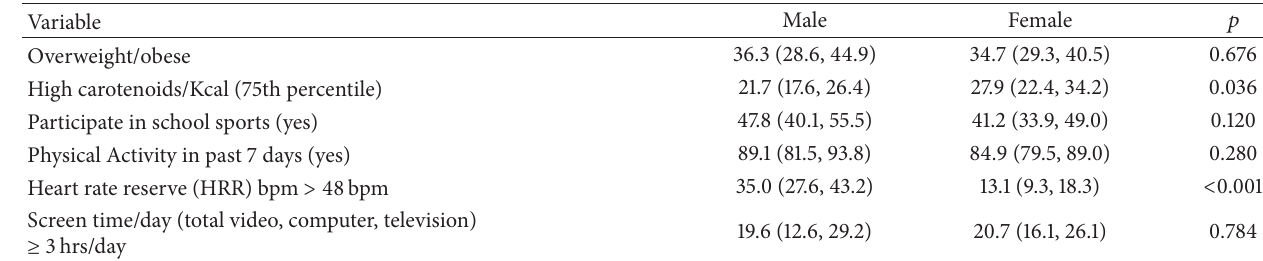
Table 2: Overweight/obesity characteristics by sex in percent (95th